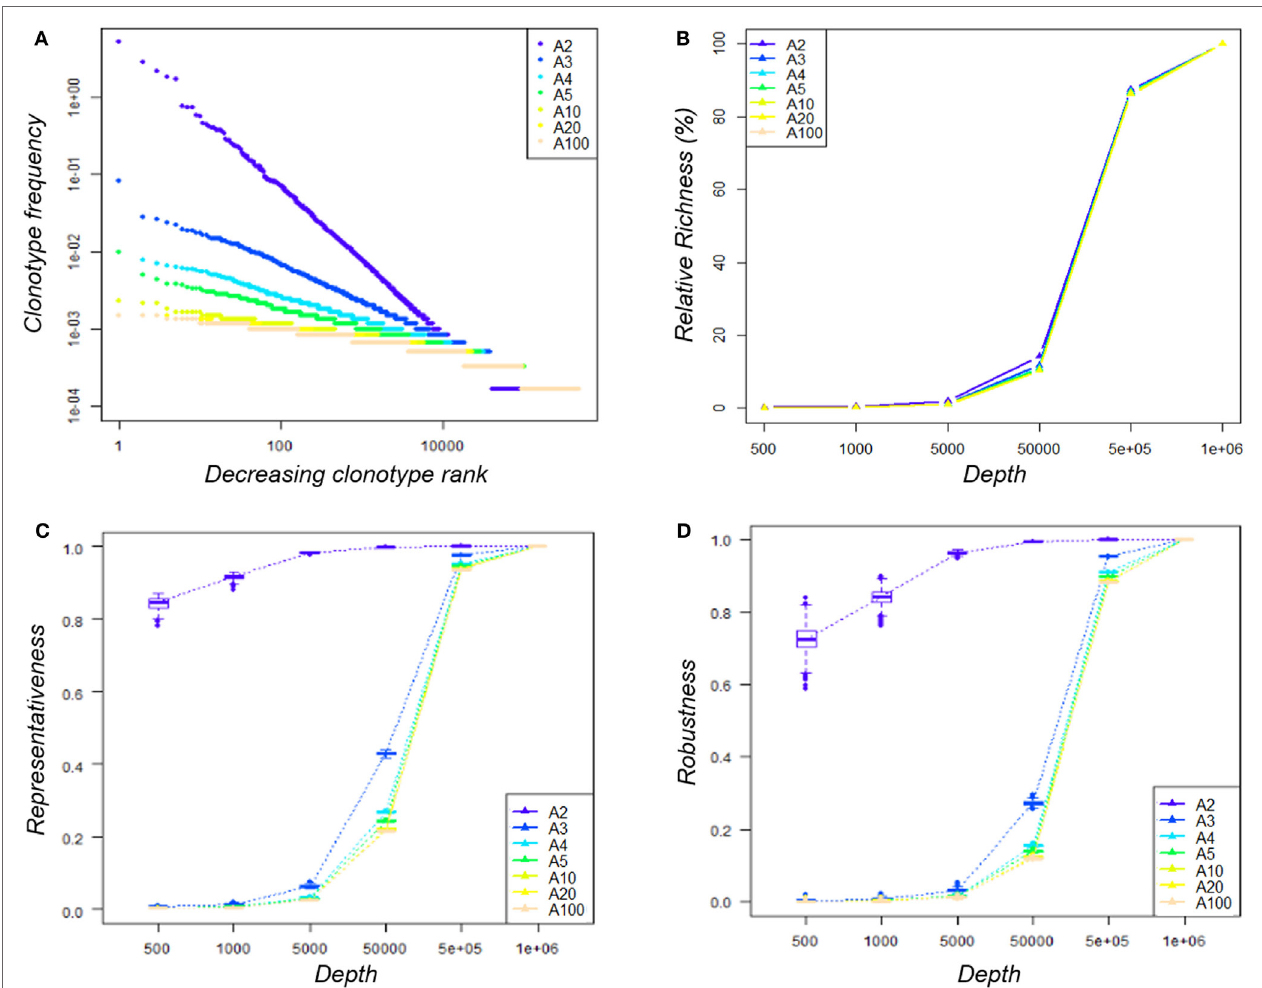
FigUre 4 | Impact of sequencing depth on the observed diversity. (a) Clonotype distribution within the seven simulated datasets—within each A -dataset, clonotypes were ranked decreasingly according to their abundance and their frequency was plotted. Both axes are log-scaled. Distributions are colored according to the A parameter used to simulate it. (B) Impact of sequencing depth on the observed clonotype richness—for a given A -dataset, clonotype richness was measured within the 100 subsamples produced for each depth and divided by that of the original dataset. The median value by depth is represented for each condition. The 95% CI was calculated but cannot be seen since it merged with the median value. (c) Representativeness of the sequencing—the Morisita–Horn similarity index was calculated between each subsample and its original dataset. Boxplots across the 100 subsamples of a given depth are color-coded according to the A condition. (D) Reproducibility of the sequencing—for each A -dataset, the Morisita–-Horn similarity index was calculated between paired subsamples of a given depth. Boxplots across the 100 subsamples of a given depth are color-coded according to the A